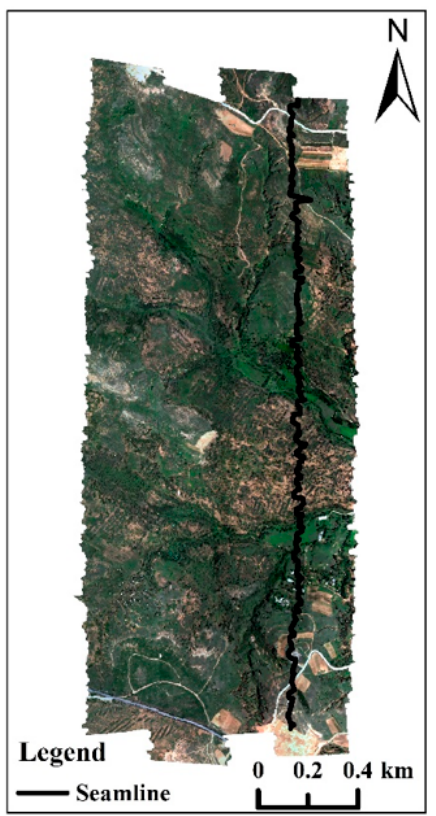
Figure 11. Schematic diagram of the seamline.